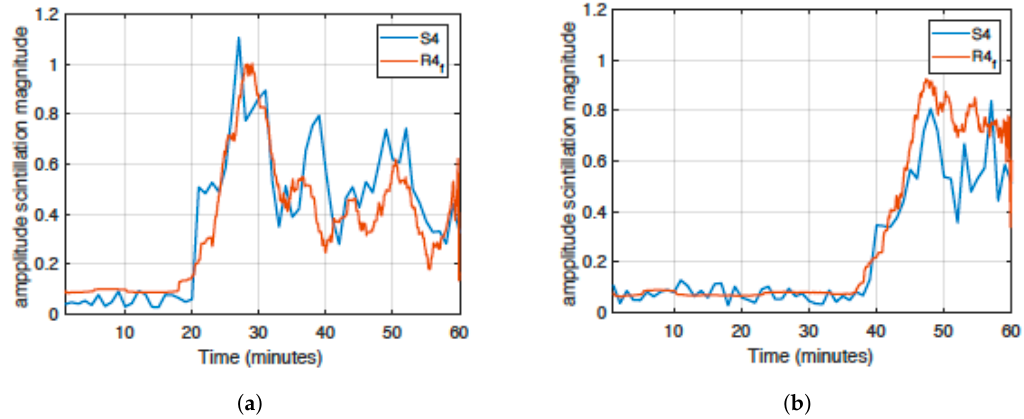
Figure 10. Comparison of S 4 and R 4 parameters after filtering: ( a ) GPS PRN 1, ( b ) GPS PRN